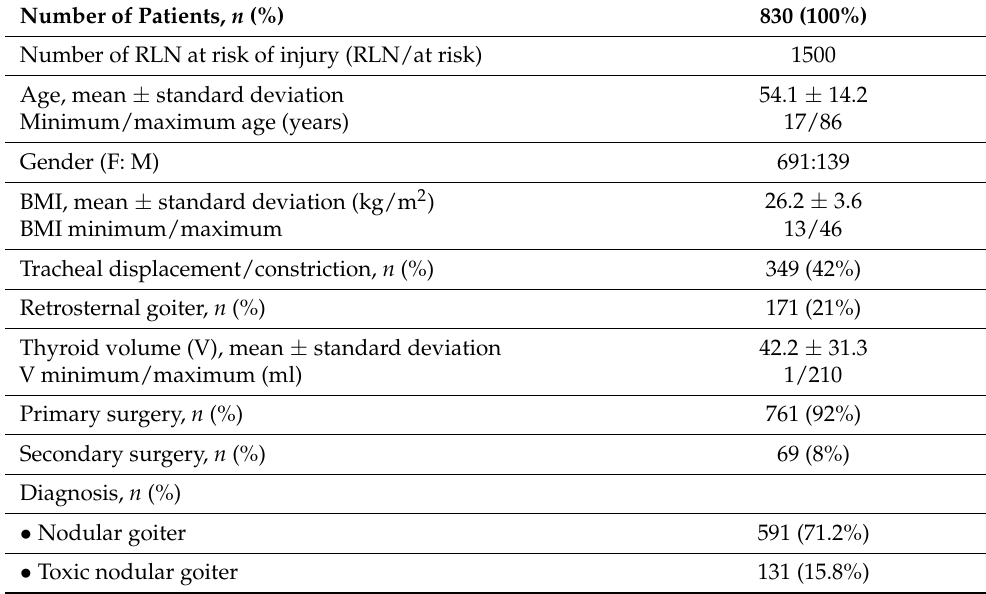
54.1 ± 14.2 17/86